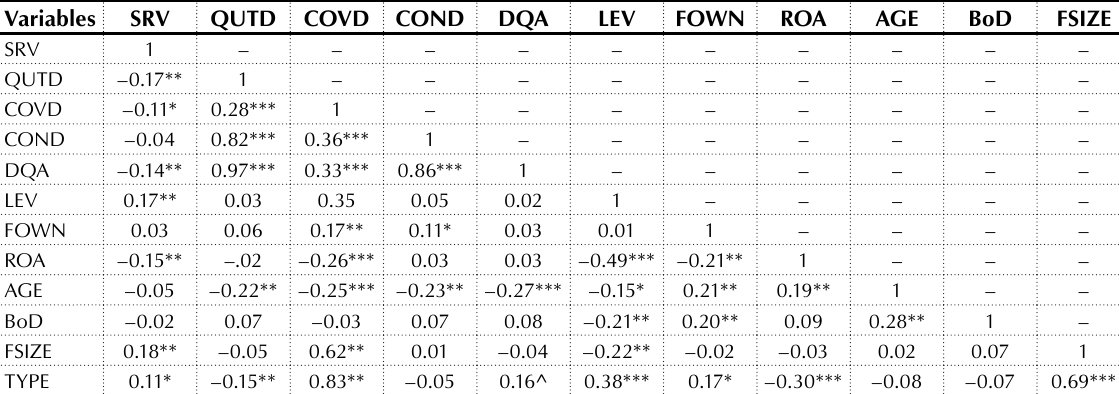
Table 5. Correlation matrix of the variables of the study